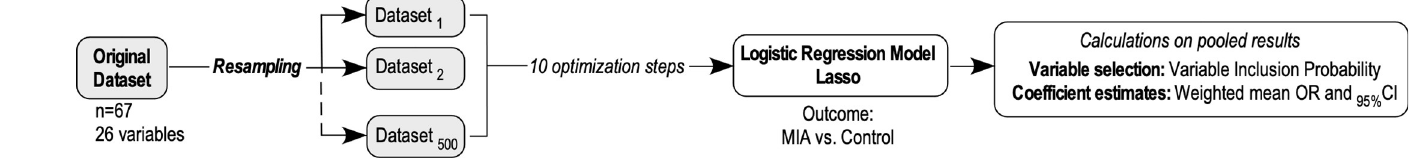
Fig 1. Methodological workflow for the multivariable analysis.